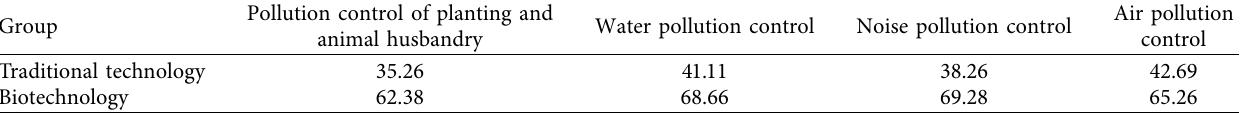
Table 2: Comprehensive analysis of environmental pollution control of rural cultural industry under different